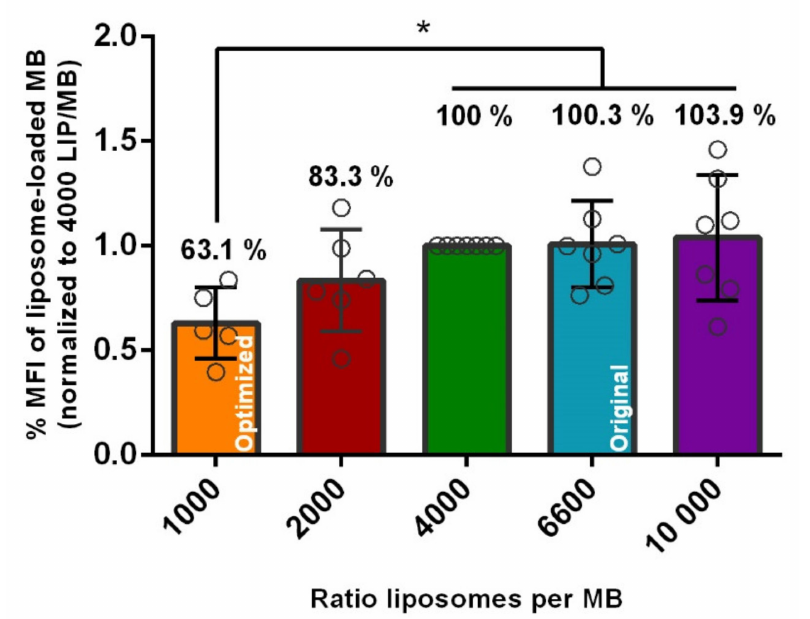
Figure 4. Optimization of liposome-loaded microbubbles to minimize the fraction of free liposomes. Flow cytometric analysis of the mean fluorescence intensity (MFI) of the different liposome-loaded microbubble formulations normalized to the MFI of the 4000 liposomes/MB formulation (green bar). Different numbers of liposomes were added to the biotinylated microbubbles and MFIs were compared via one-way ANOVA with Tukey’s correction for multiple testing, at least n = 5 replicates (dots represent individual data points) for each volume, * represents p <